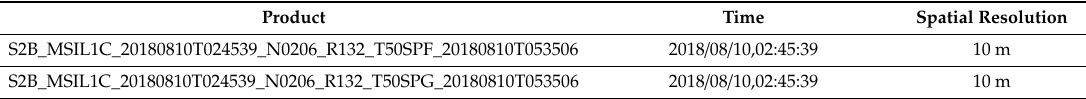
Table 2. Information of Sentinel-2